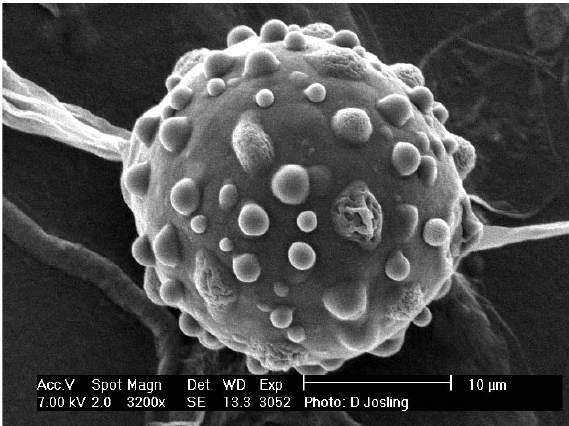
FIG. 2 SEM of a chlamydospore from a South African isolate of Duddingtonia